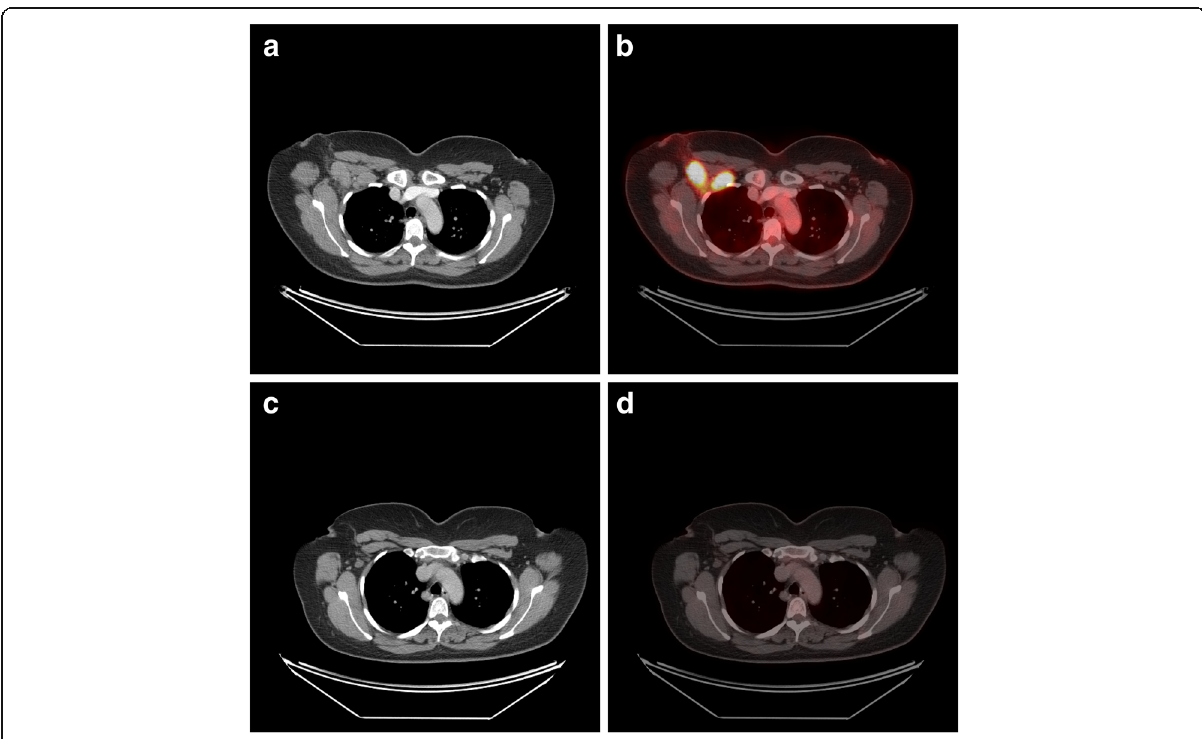
Fig. 5 A 37-year-old patient, newly diagnosed Hodgkin lymphoma. a , b His initial study revealed multiple metabolically active FDG avid lymph nodes which are seen at right axillary lymph nodes, largest measures 3.5 × 2.6 cm with SUV max 7.05. c , d His interment study reveals complete metabolic resolution; however, anatomically still non-FDG avid axillary lymph nodes are noted that have markedly regressed in size; the largest measures 1.6 × 0.65 cm compared to 3.5 × 2.6 cm in previous study. This study was partial regression by CT and total regression by